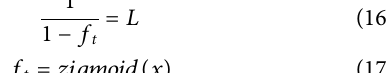
FIGURE 3 | Structure of